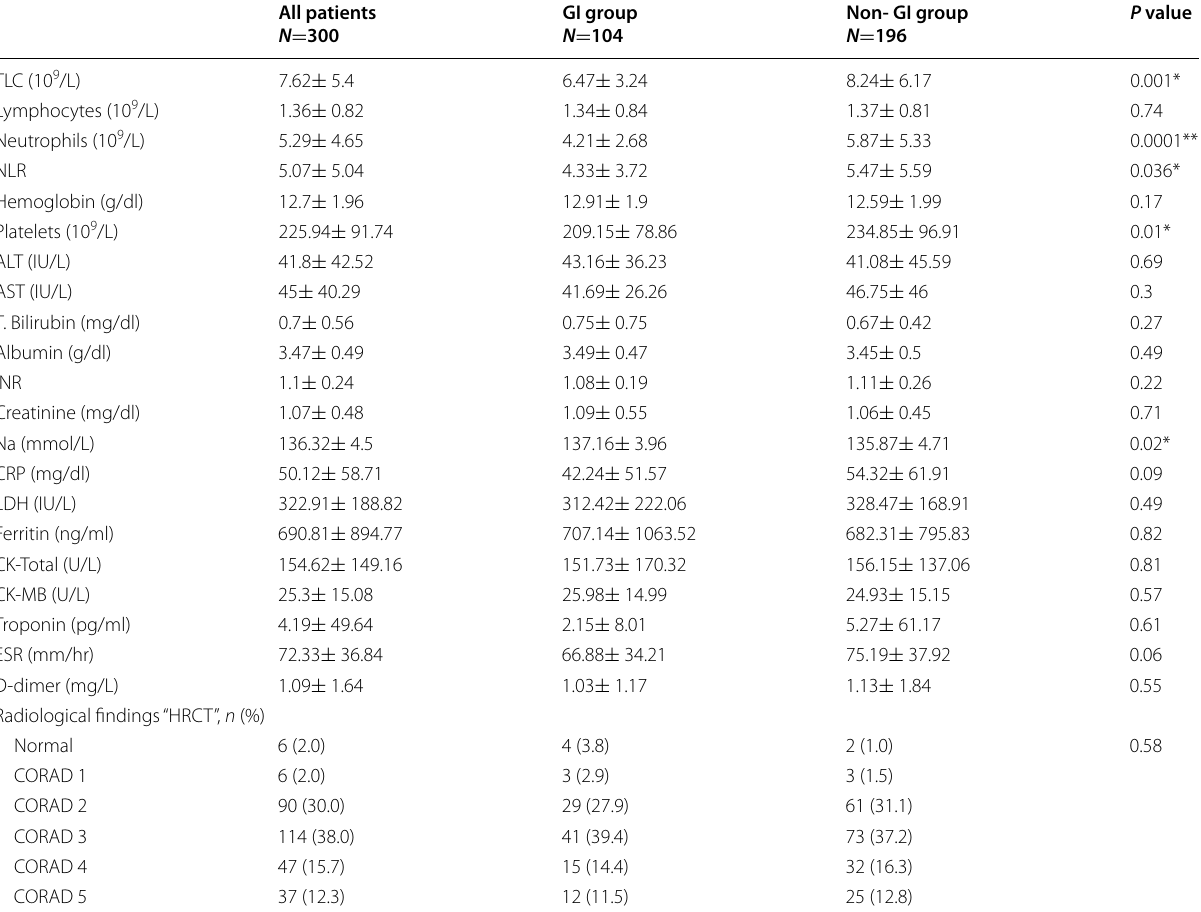
Table 5 Laboratory and radiological findings in patients with